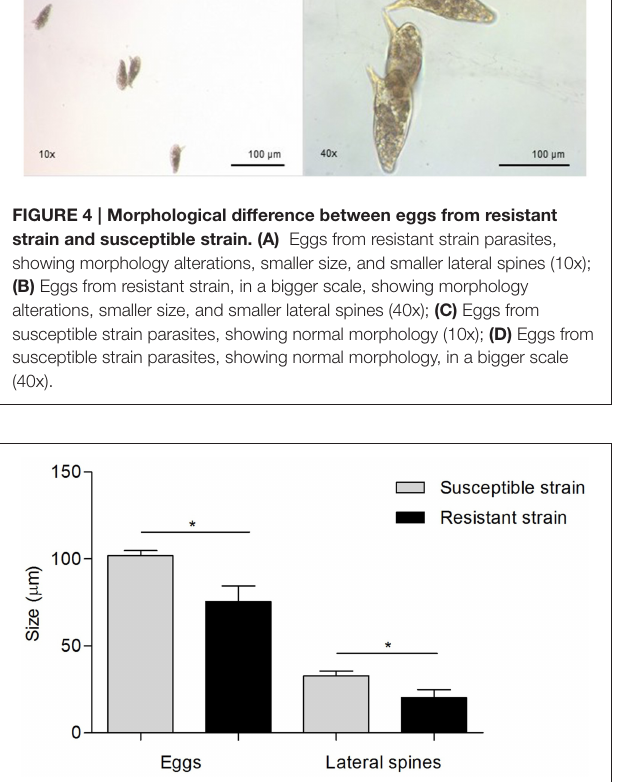
FIGURE 5 | Difference in egg morphology of S. mansoni resistant strain and susceptible strain. Gray bars, measurements of eggs and lateral spines from susceptible strain worms; Black bars, measurements of eggs and lateral spines from resistant strain worms. Data was presented as mean ± SD. Statistical analysis was performed by parametric t -test, for independent simples, whose level of significance was set at p < 0.05. * indicated p <